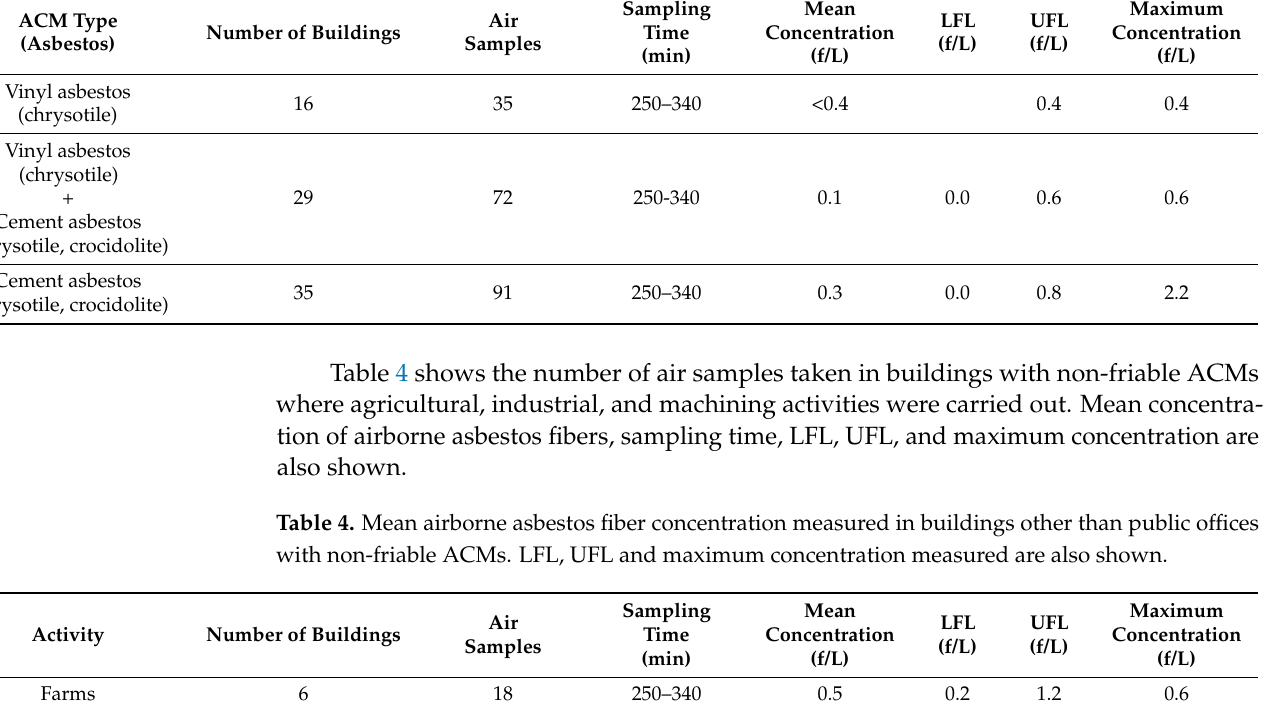
Figure 6. SEM image of airborne chrysotile fibers collected in a building with non-friable ACMs on polycarbonate filter ( a ) and related EDS spectrum ( b ).